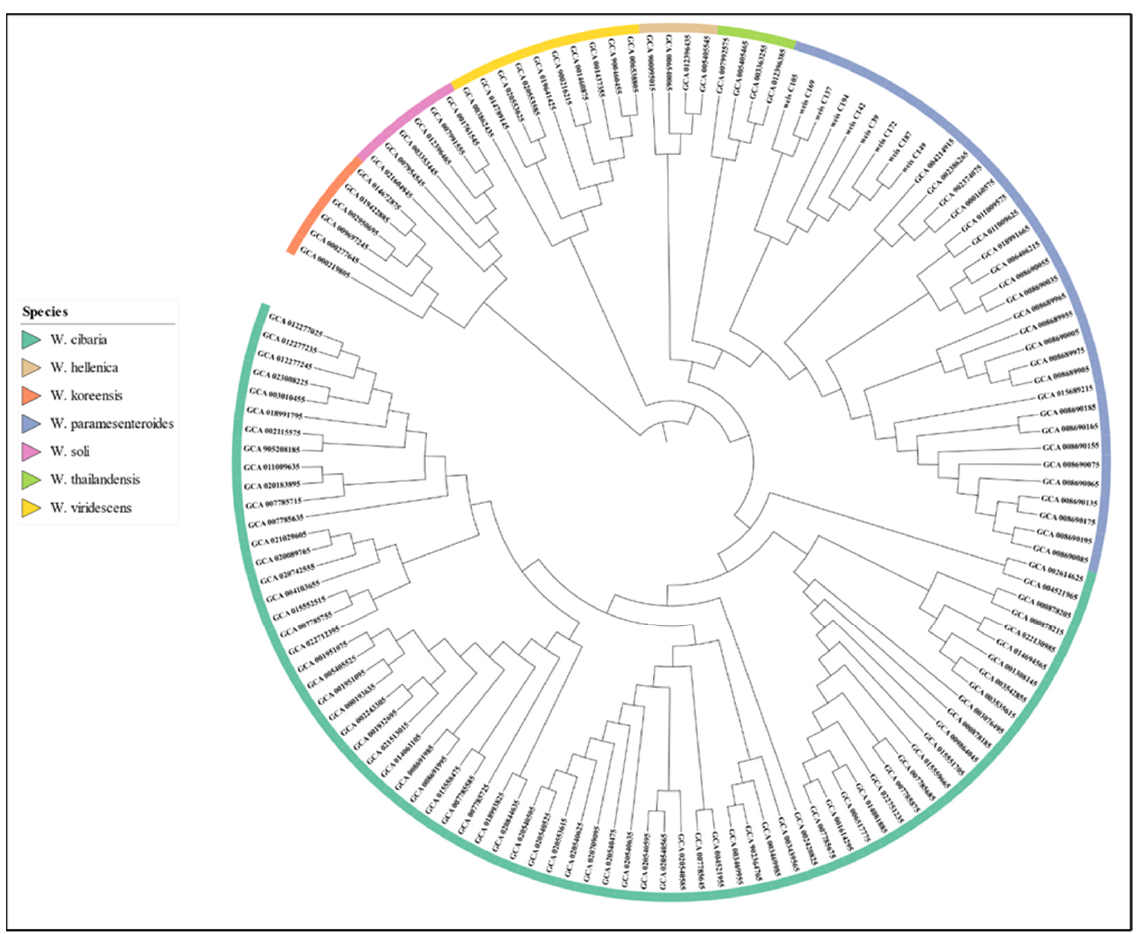
Figure 2. Phylogenetic tree including the 163 Weissella spp. isolates. The colored ring indicates the isolates’ species according to the